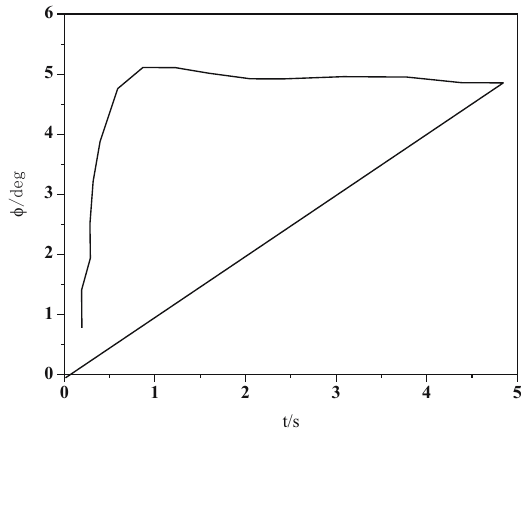
Figure 8: Pitch control